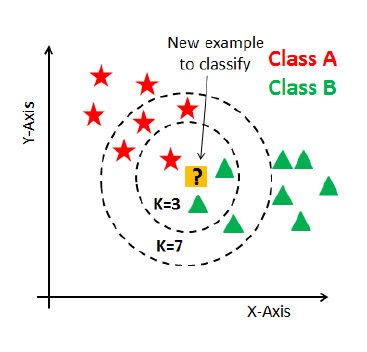
Figure 11. K-Nearest Neighbor Algorithm